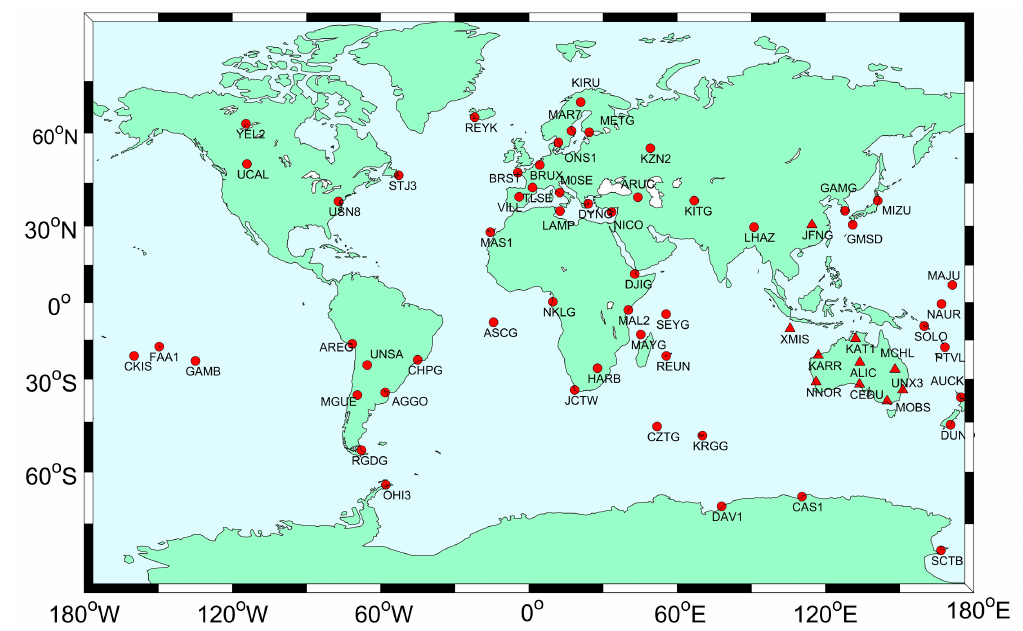
Figure 10. The distribution of the selected GNSS stations (as of July 2017).